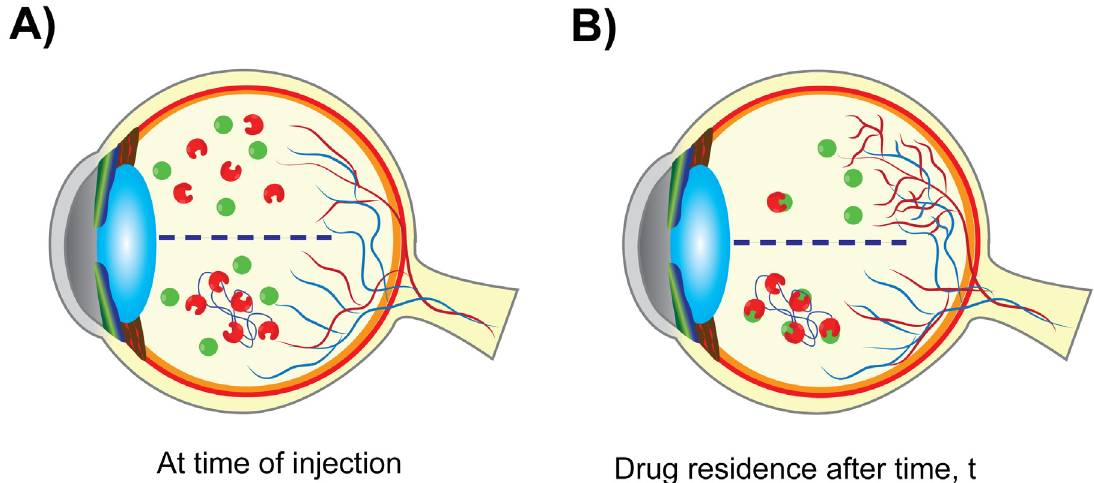
Fig 5. Schematic demonstrating the proposed mechanism of mvsFlt action. A) sFlt (red, unconjugated) and mvsFlt (red conjugated blue chain of HyA) are injected into a diabetic retina where there is a high concentration of VEGF (green circles). B) After a given time, t, the majority of the sFlt has been cleared from the vitreous and VEGF is thus able to induce blood vessel growth. mvsFlt has a longer residence time in the vitreous and is able to bind and inhibit VEGF over much longer periods of time, leading to prolonged inhibition of retinal